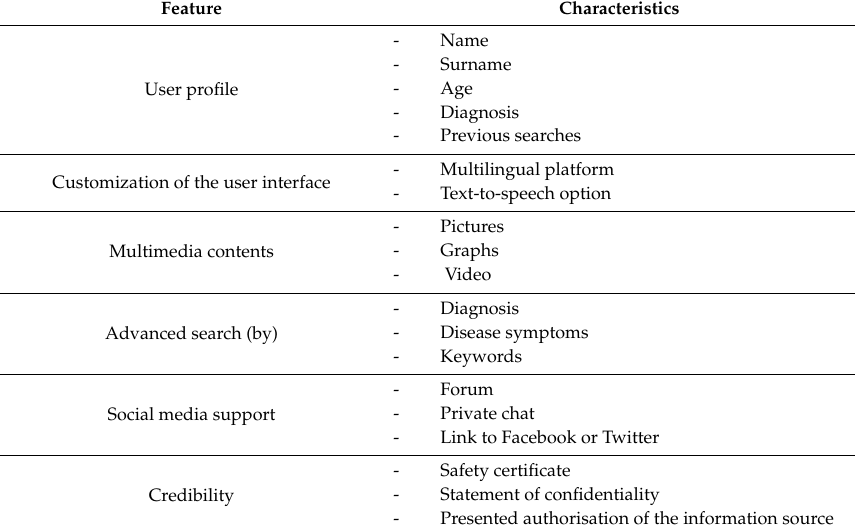
Table 1. Interview participants’ opinion regarding the features and personalized information needed in